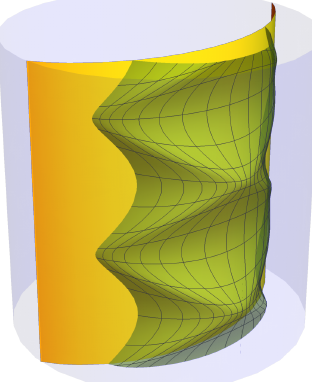
Figure 5. Oscillator excitation above the ground